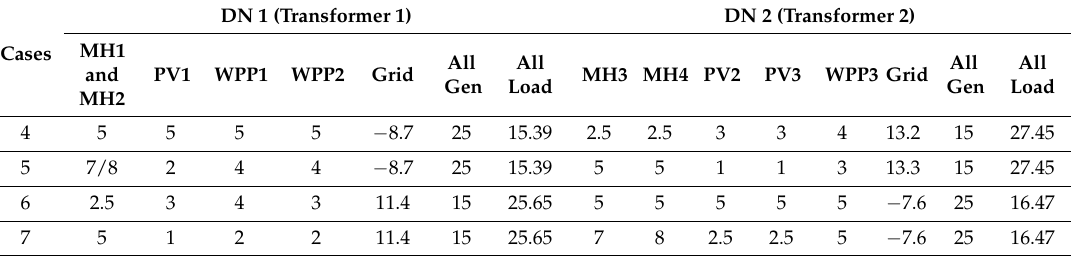
Figure 12. The 20 kV distribution test network: high generation penetration. Table 6. Designed scenarios for the high generation penetration configuration (data in MW).